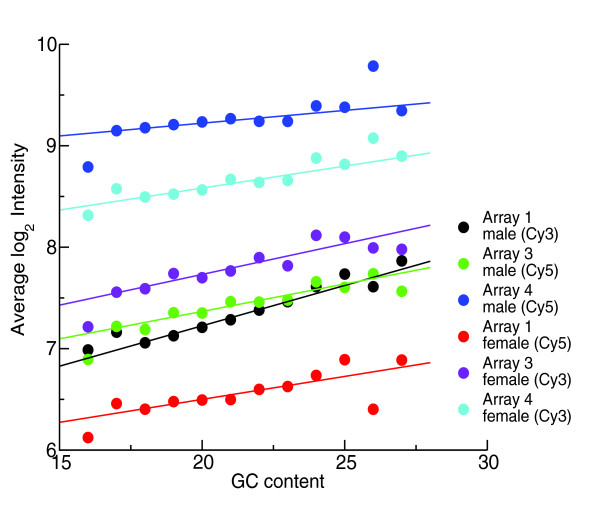
Linear dependence of signal intensity on GC content for negative control probes. Average log2 signal intensity of NCPs with indicated GC content, for six channels.